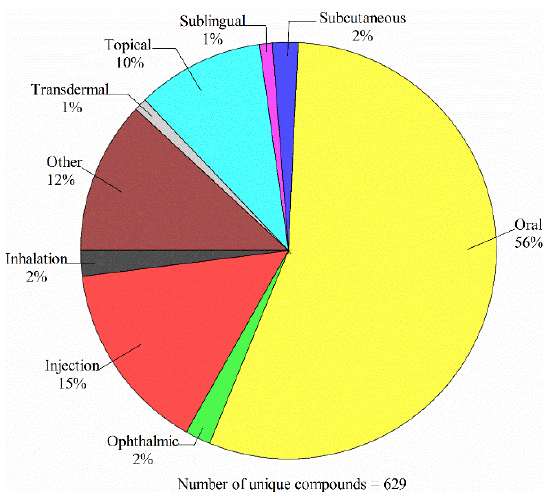
Figure 1. Administration routes and the corresponding ratios for those unique drugs approved by the FDA in 2018.